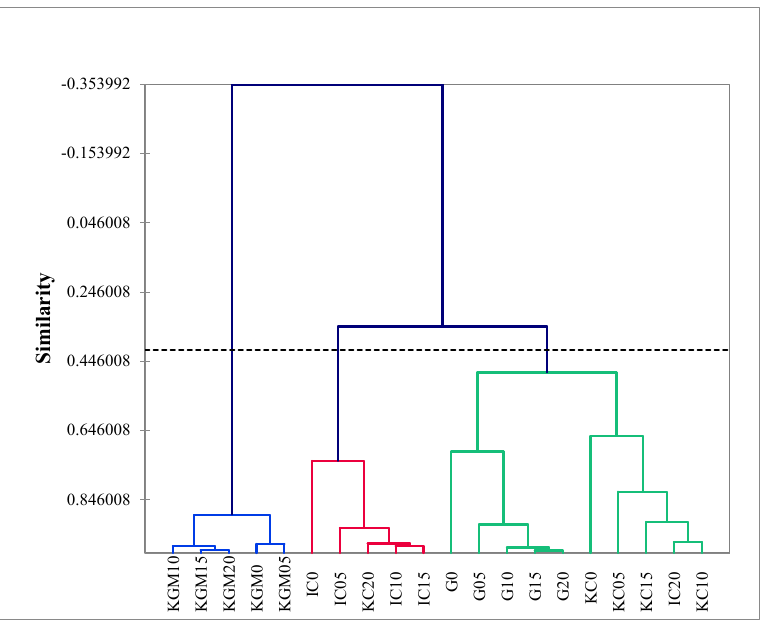
Figure 3. Dendrogram from agglomerative hierarchical cluster analysis (unweighted pair–group average method) of 20 model confectionary gel samples by sensory attributes based on gel type. Similarity based on Pearson correlation coefficient. G = gelatin, IC = ι -carrageenan, KC = κ -carrageenan, KGM = konjac glucomannan.